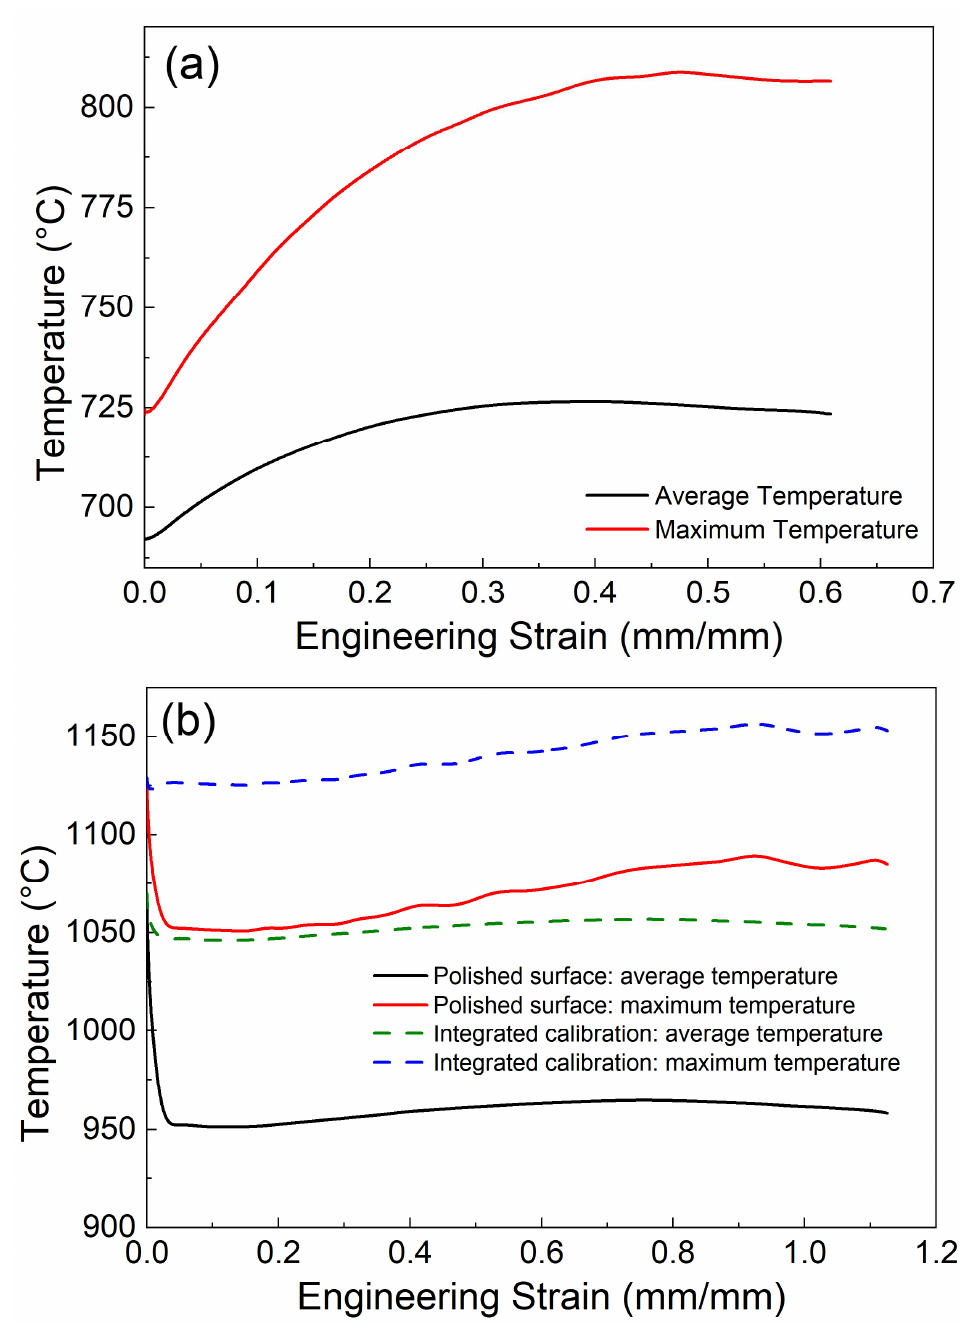
Figure 13. Average and maximum temperatures as a function of engineering strain for ( a ) a specimen with constant emissivity and ( b ) a specimen where rapid change in emissivity causes a significant drop in radiometric temperature in the beginning of deformation. The solid lines represent the temperature values calibrated by the smooth surface-temperature calibration and the dashed lines represent the values obtained from the integrated calibration.